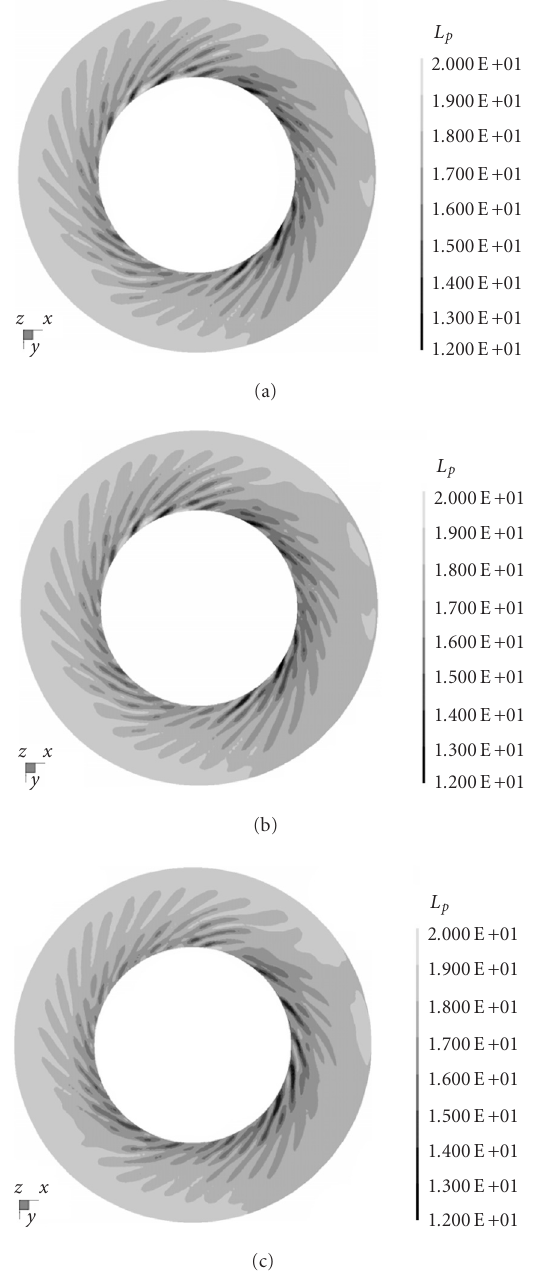
Figure 15: Static pressure on the vaneless di ff user center plane at design conditions: (a) starting position, (b) 1 / 3 revolution, and (c) 2 / 3